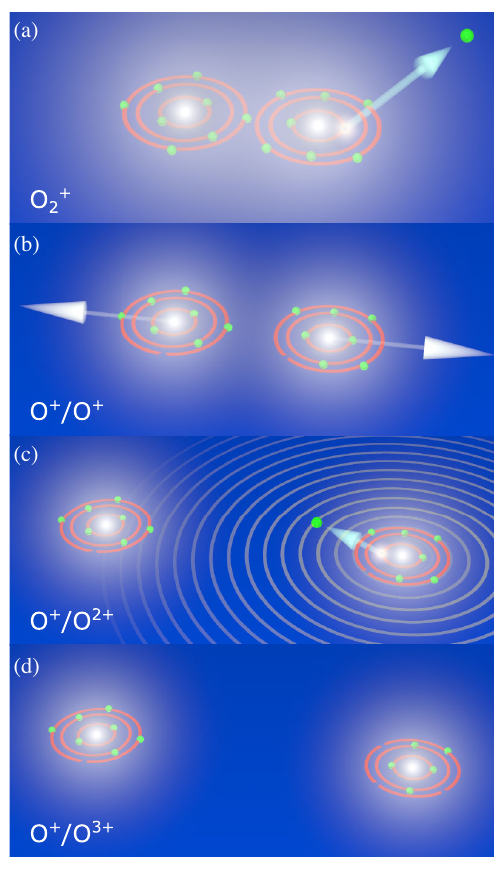
FIG. 1. Scheme of photoelectron diffraction imaging during Coulomb explosion of O 2 . (a) A K -shell electron is ionized upon irradiation with XFEL light. (b) After the innershell vacancy has been filled after a first Auger decay, the molecule is doubly charged and fragments in a Coulomb explosion. (c) During the fragmentation a second photon triggers the emission of another K -shell electron illuminating the molecule from within. (d) A further, subsequent Auger decay yields the observed final O þ = O 3 þ state in which the Coulomb explosion continues until the ions are well separated and finally detected. Steps (a) to (c) occur during a single XFEL light pulse, i.e., within approximately 25